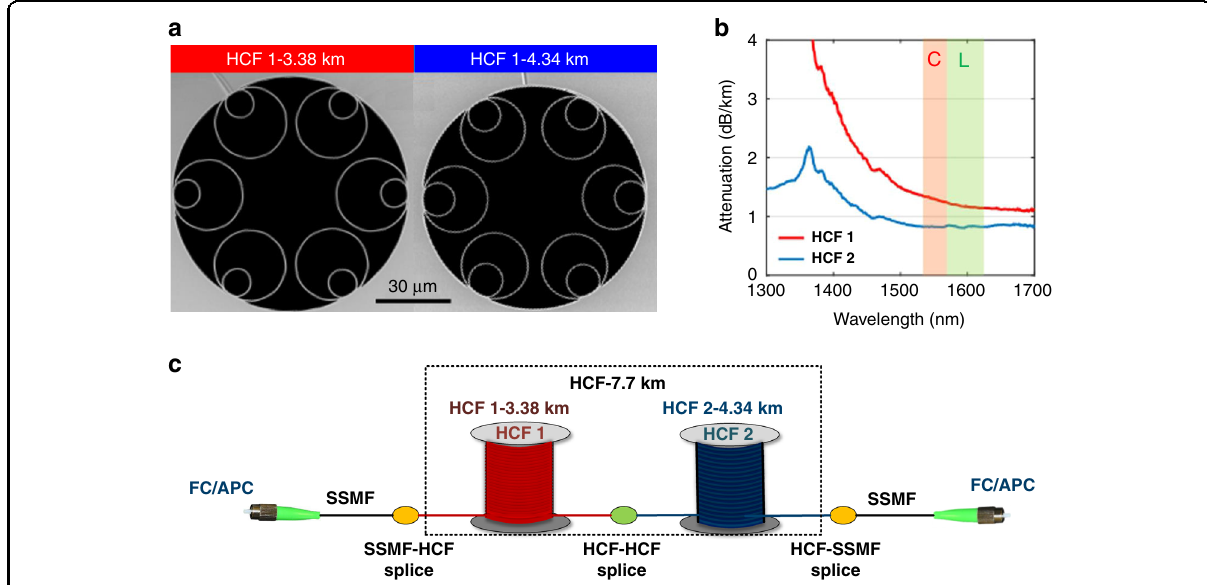
Fig. 10 Fibre sample details. a Cross-sectional SEMs of the two HCF (NANF-type) samples. The length of the HCFs is 3.38 km and 4.34 km, respectively. b HCF attenuation versus transmission wavelength measured on both HCF samples with a cutback method. c Details of the 7.7-km HCF link. The loss of SSMF-HCF and HCF-HCF splices are 1 and 0.2 dB, respectively. FC/APC: fi bre connector with angled physical contact